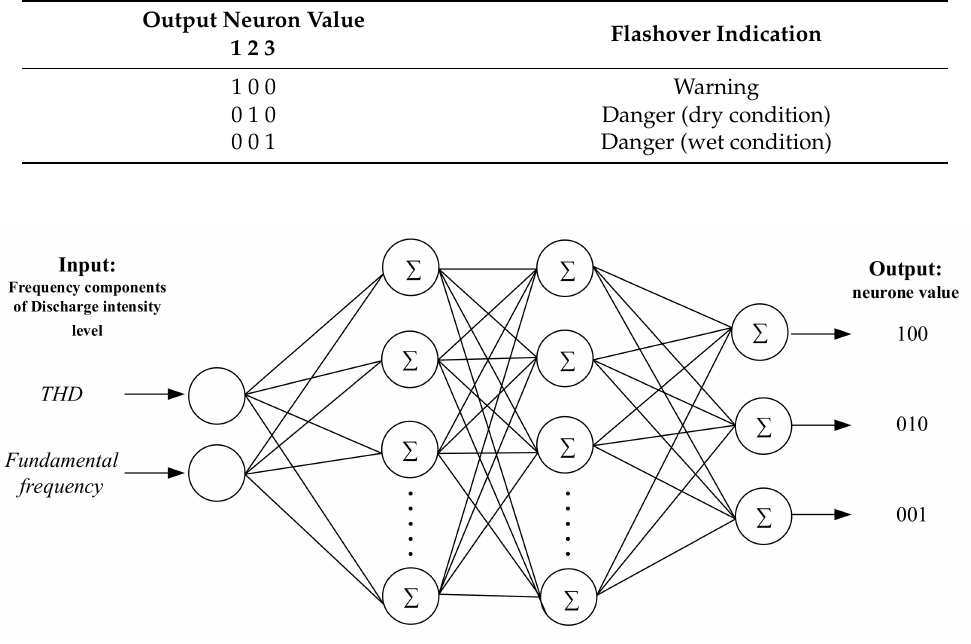
Relationship between the output values of artificial neural network (ANN) and flashover indication.